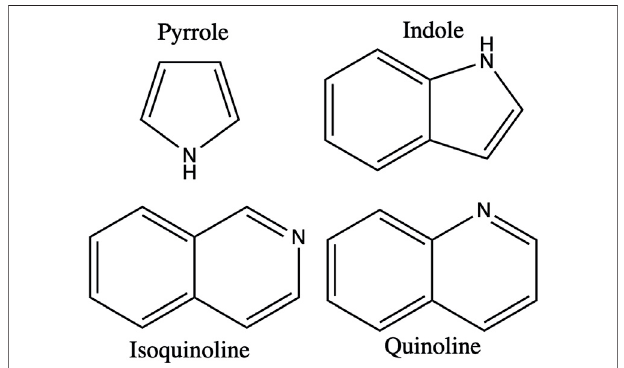
FIGURE 1 | Basic structure of alkaloids.